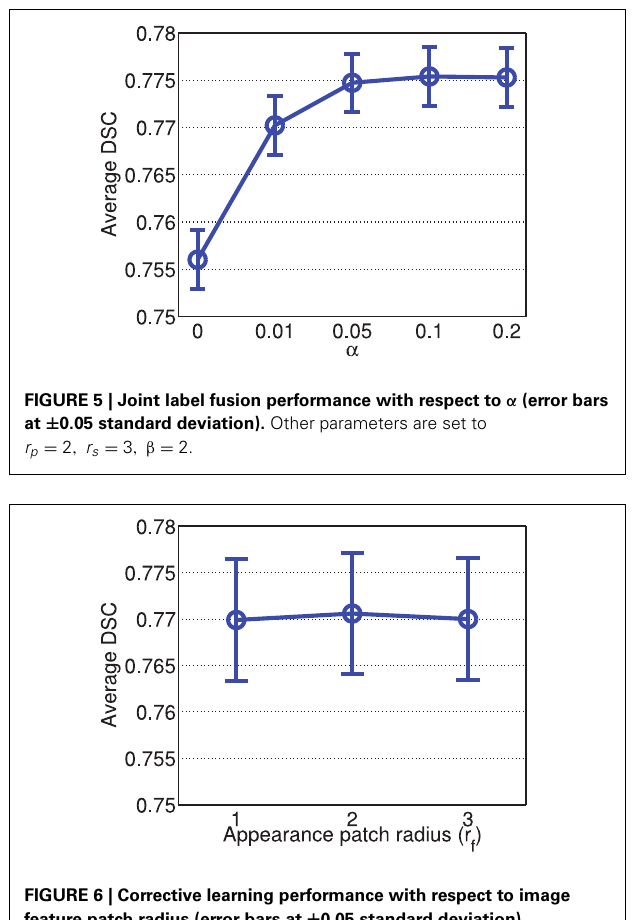
FIGURE 6 | Corrective learning performance with respect to image feature patch radius (error bars at ± 0.05 standard deviation). Parameters for joint label fusion are set to r p = 2 , r s = 3 , α = 0 . 1 , β =